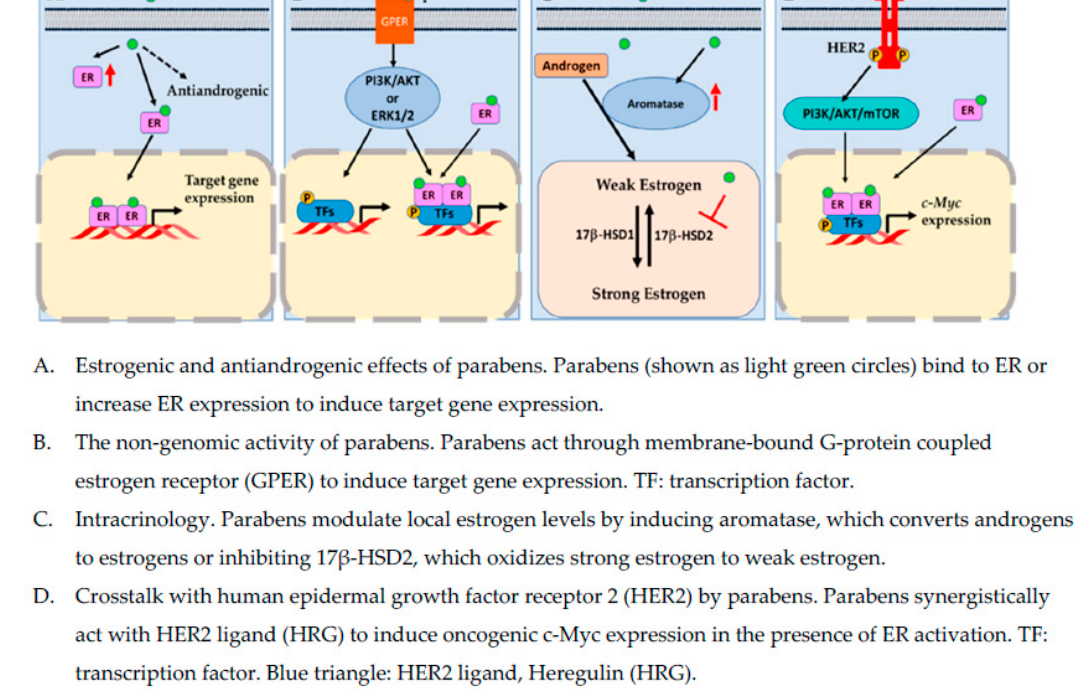
Figure 1. Molecular mechanisms by which parabens act in breast cancer cells.